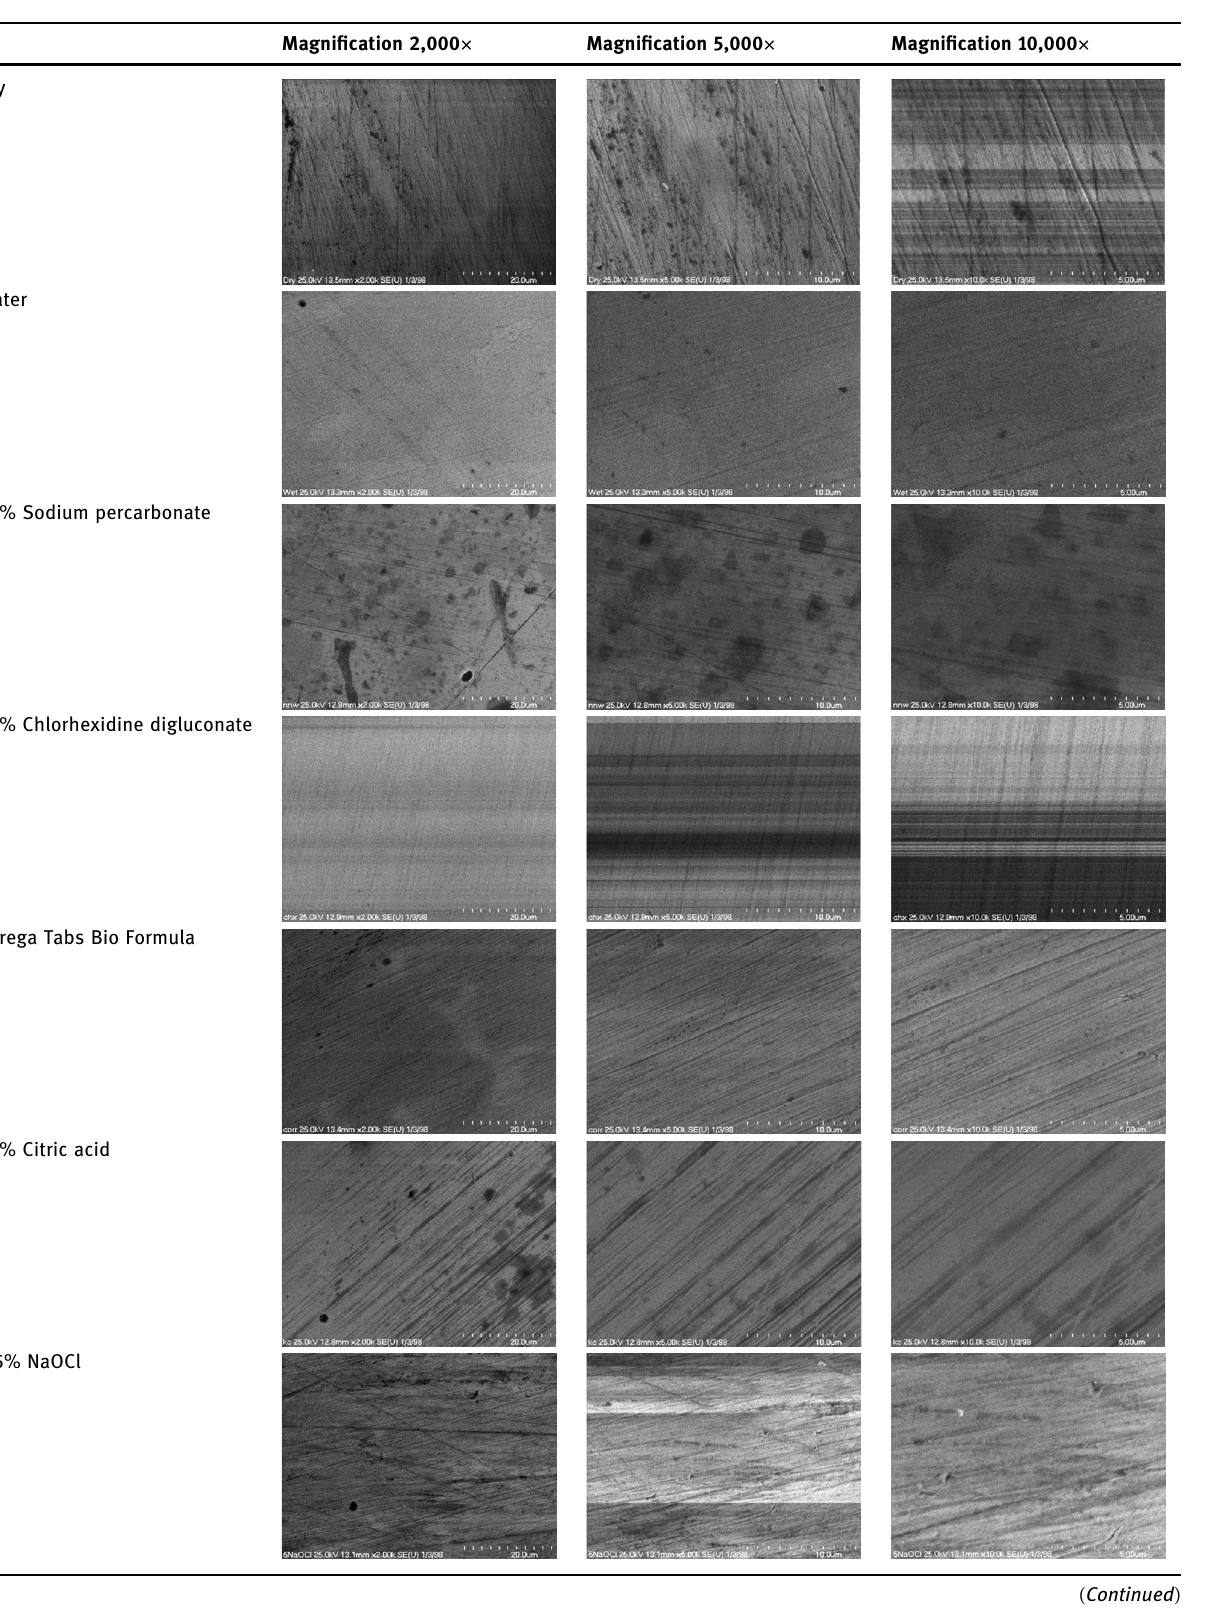
Table 10: SEM analysis of Co – Cr samples stored in di ff erent solutions at magni fi cations 2,000 × , 5,000 × , 10,000